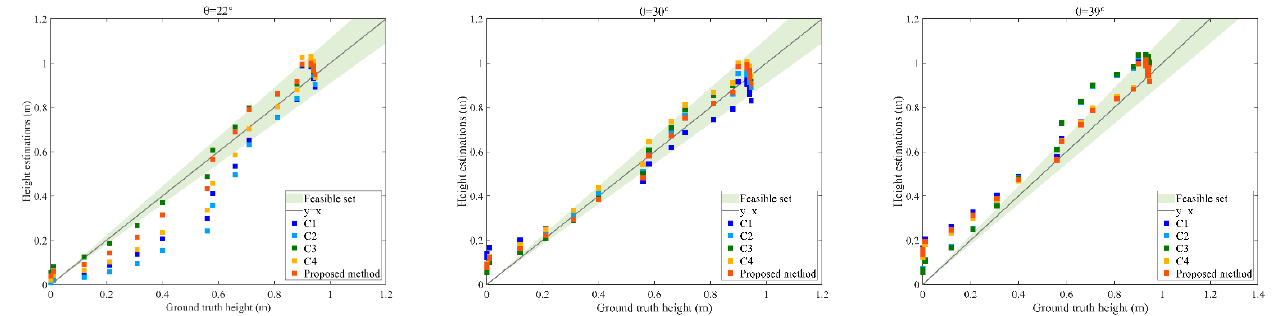
Figure 7. Correlation plots of the rice height estimations with respect to the ground-truth data. C1–C4 correspond to the cases of the three manually selected interferograms that were used to estimate the rice height evolution, whereas the proposed method corresponds to the proposed model with the proposed date selection criterion.